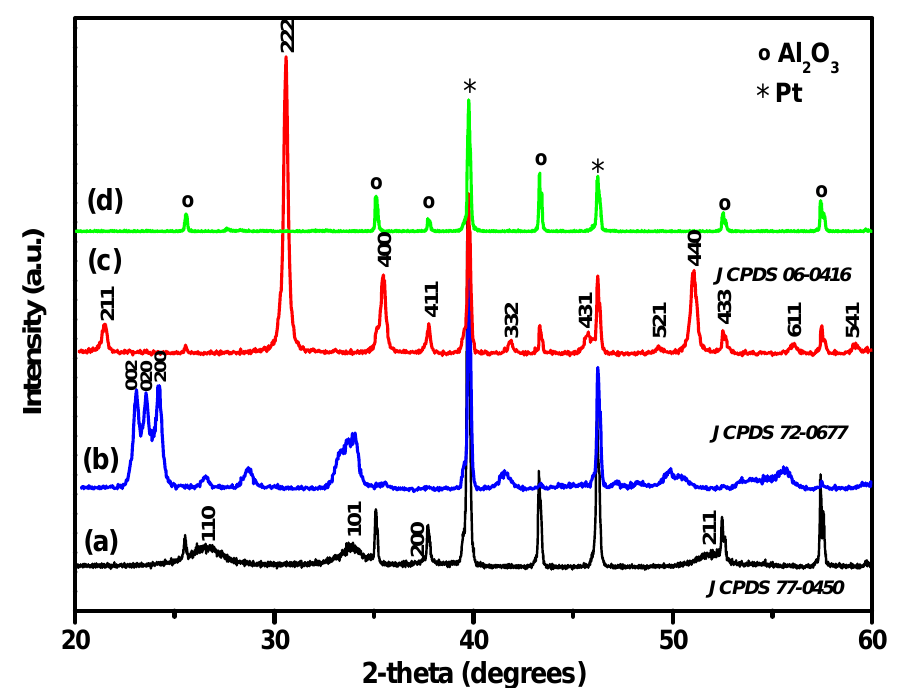
(c) In O films and (d) Pt-Al 3 2 3